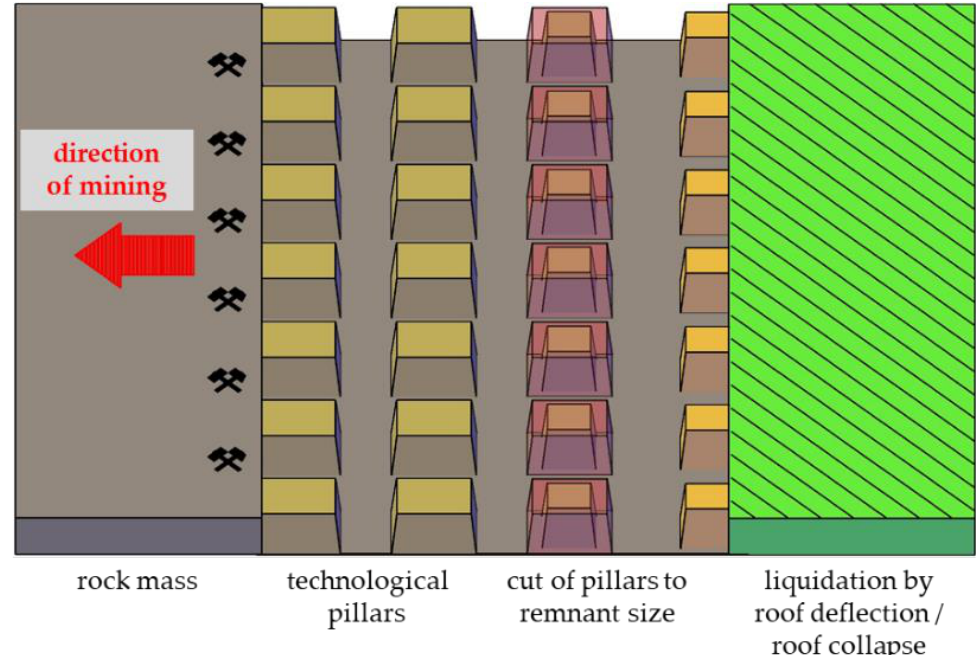
Figure 1. The schematic presentation of the room-and-pillar mining system with roof deflection. The exact dimensions of the pillars and workings were adjusted to the local mining and geological conditions. At the moment, in Polish copper mines, there are over 20 vari- ants of room-and-pillar mining systems that are fit to the local strength of the rock, height of the deposit, presence of tectonic disturbances, and the presence of a mined-out area in the surrounding of the analyzed mining panel.